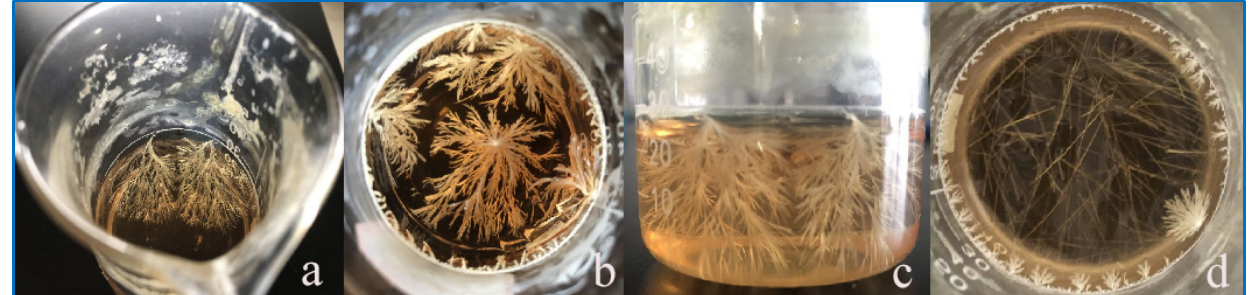
Figure 2. EVA hang-wall growth ( a ) at air/liquid interface or bulge growth ( b , c ) on liquid surface, and occasionally acquired linear EVA crystals ( d ) in CMCS/EVA con-mixture gels.